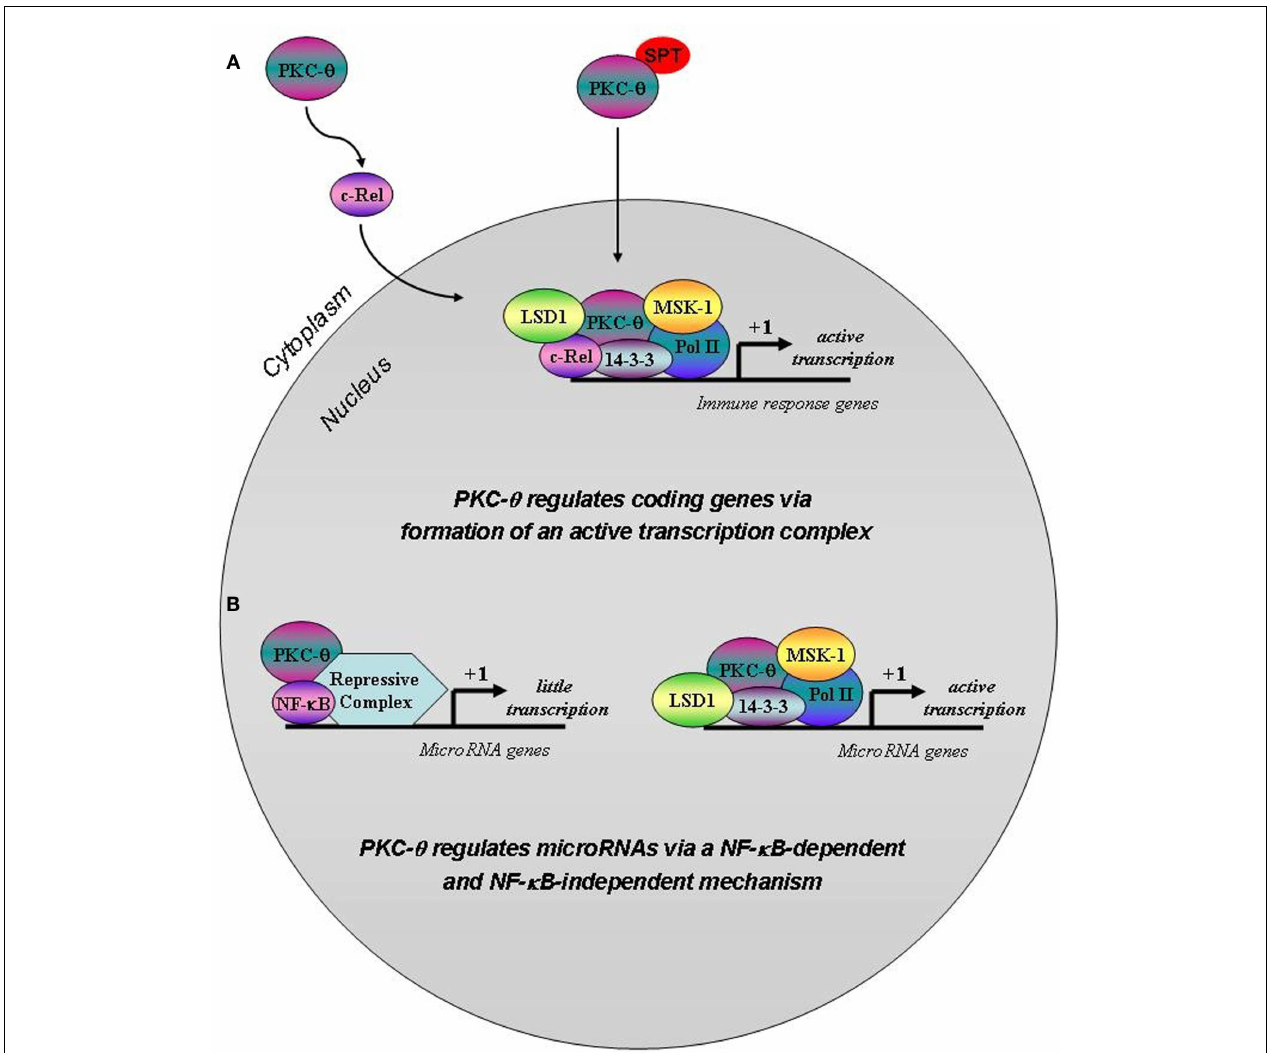
complex on coding genes to enable chromatin accessibility and gene transcription. (B) FollowingT cell stimulation, there is a reduction in PKC- θ binding to chromatin at microRNA genes compared to restingT cells. Instead, NF- κ B is recruited via a distinct transcription factor motif and may form part of a repressive complex on these genes to dampen gene transcription.When NF- κ B is removed from this system, more of the active PKC- θ complex assembles on microRNA gene promoters thereby overcoming transcriptional